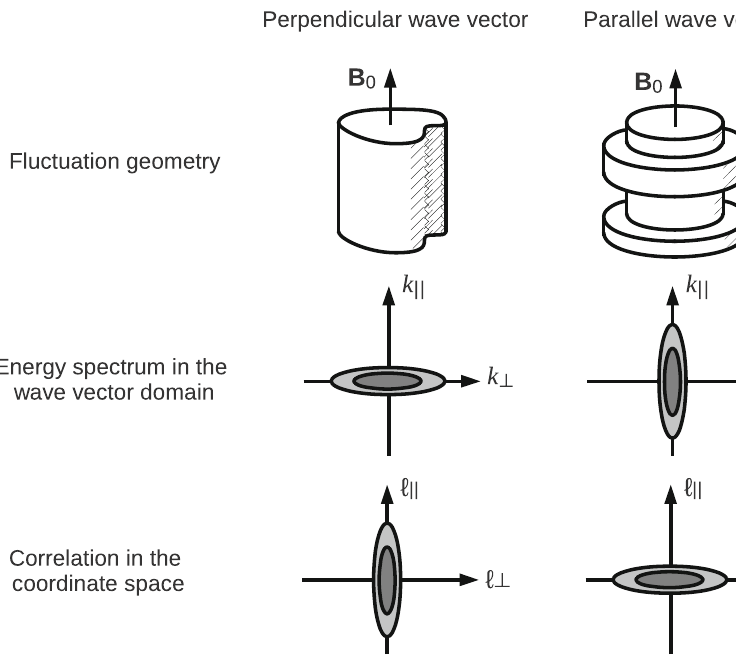
Fig.12 Fluctuationvisualizations,theenergyspectrainthewavevectordomain,andthespatialcorrelations for the perpendicular wavevector geometry (or the two-dimensional geometry) and the parallel wavevector geometry (or the slab